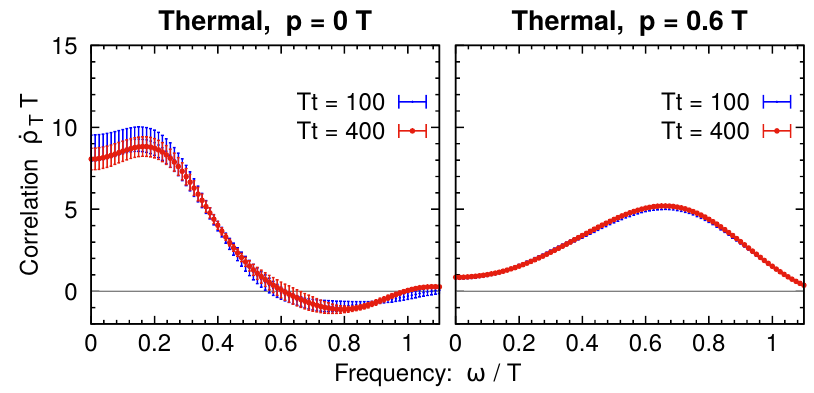
Figure 11 . The correlator ˙ ρ T as a function of frequency for momenta p = 0 T (left) and p = 0 . 6 T (right) for a 2+1D theory in classical thermal equilibrium. Time translation invariance is shown by comparing the correlations at two different times. One finds the same properties as for the non-equilibrium case considered in the main part of the paper. Note that in the right panel the curve for T t = 100 is barely visible because it accurately coincides with the curve for T t = 400